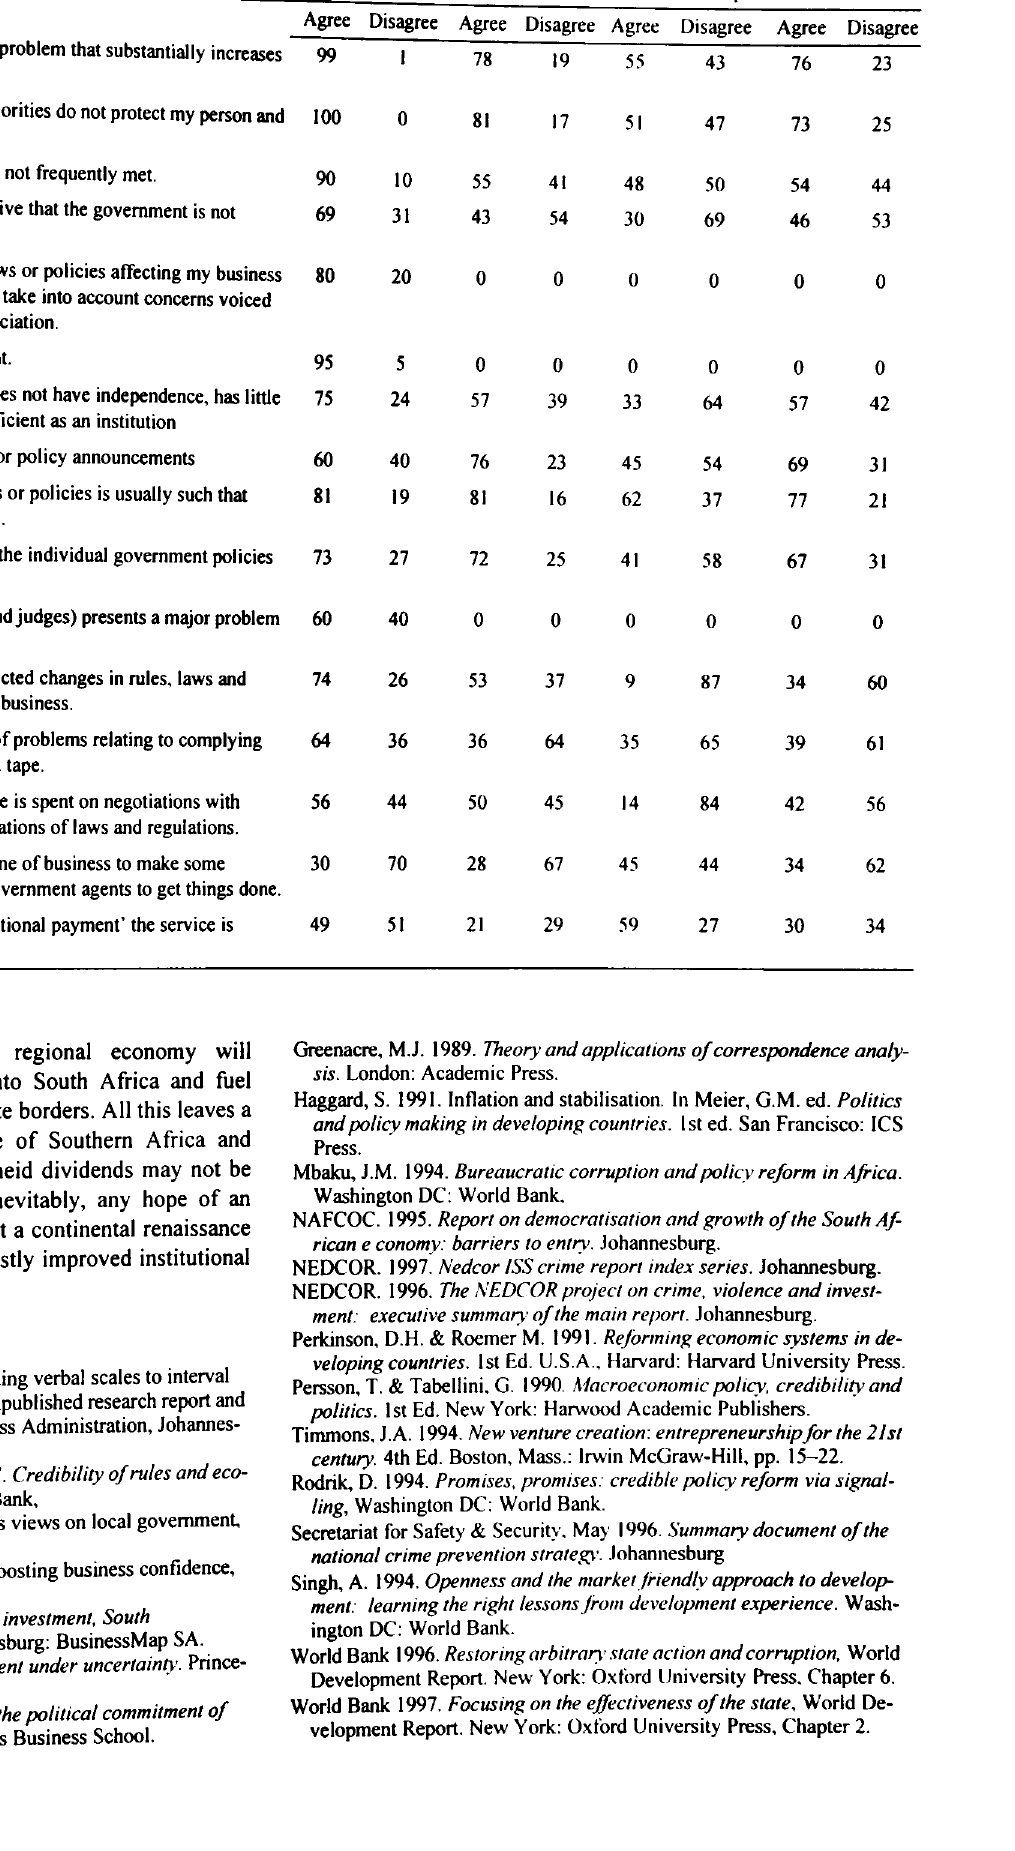
Table 8 Percentage of respondents that ticked three answers in agreement to statement and those that ticked three answers in disagreement Ranking